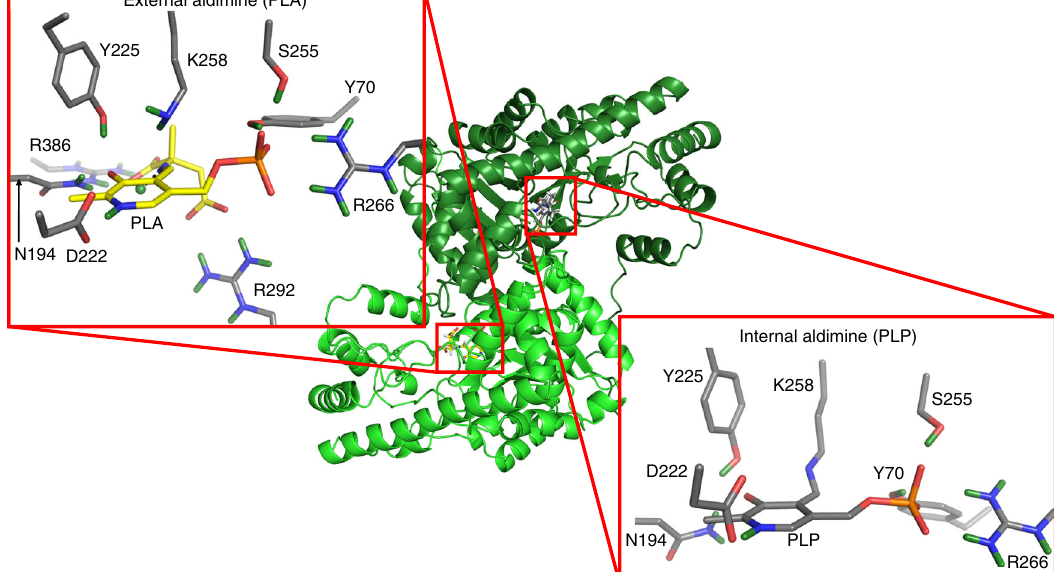
Fig. 1 Structure of AAT with α -methylaspartate. The PLP cofactor in the external aldimine (chain A in light green) and the internal aldimine (chain B in dark green) forms are shown in yellow and gray carbon scheme, respectively. In the external aldimine, R292 and R386 interact directly with the carboxylate groups of α -methylaspartate. These interactions are not present in the internal aldimine. Here and in Figs. 2, 3, and 5, the deuterium atoms are colored green and the external aldimine is labeled as